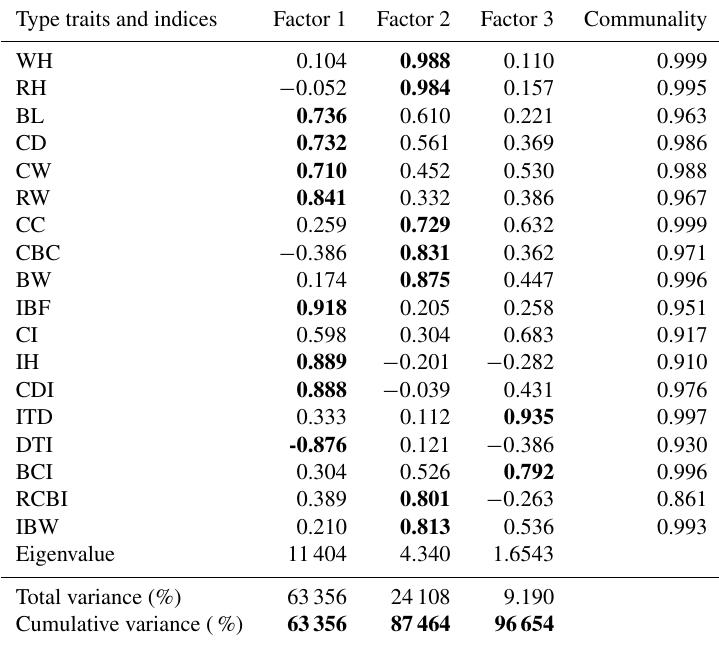
Table 4. Eigenvalues, total and accumulated variance, and factor and factor loadings for the morphometric parameters (measures and indices) of six sheep breeds. Type traits and indices Factor 1 Factor 2 Factor 3